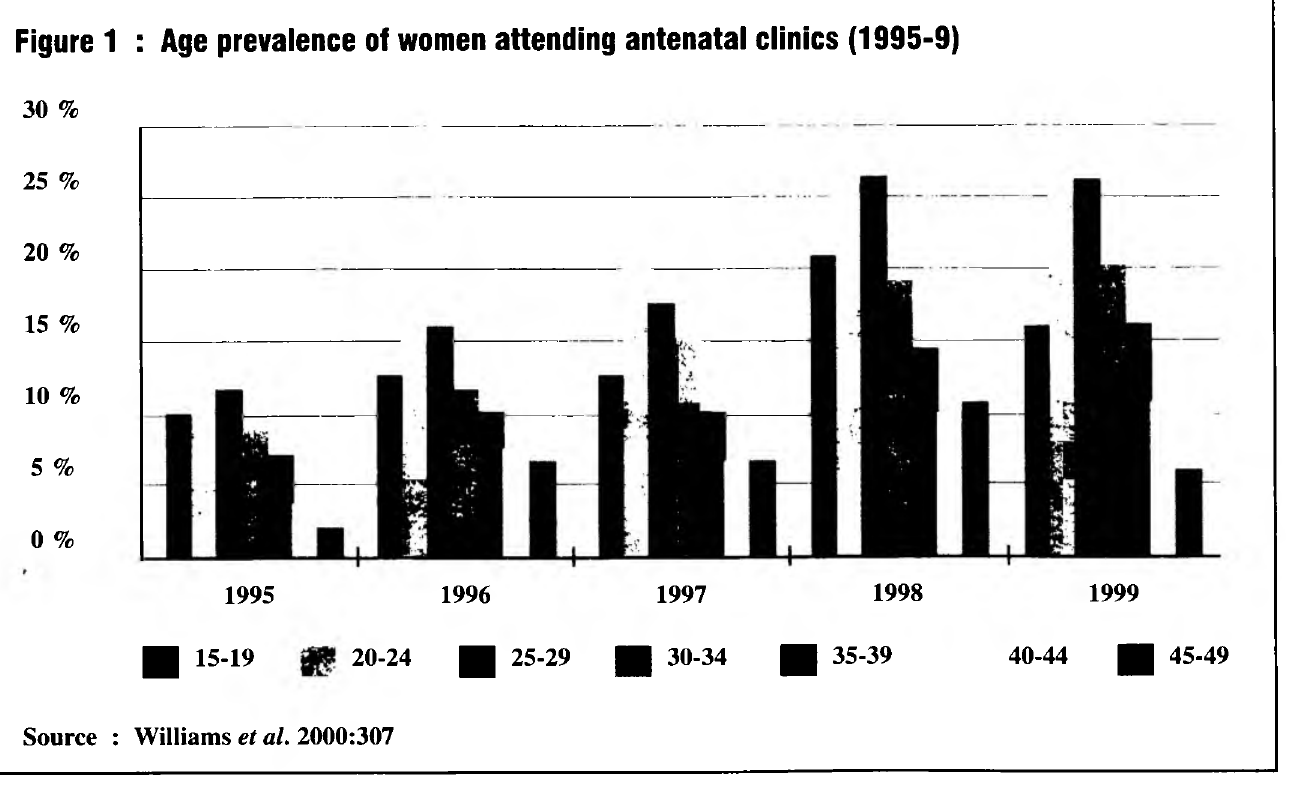
Figure 1 : Age prevalence of women attending antenatal clinics